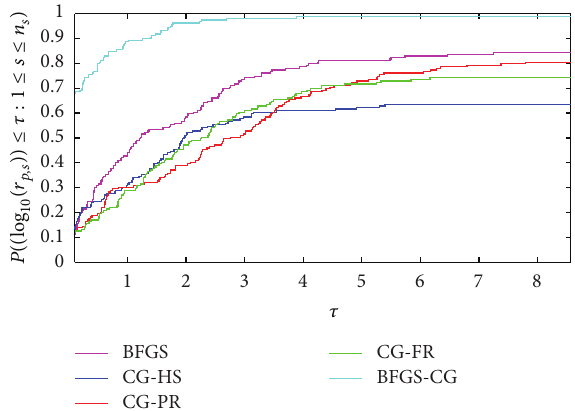
Figure 1: Performance profile in a log 10 scale based on iteration.